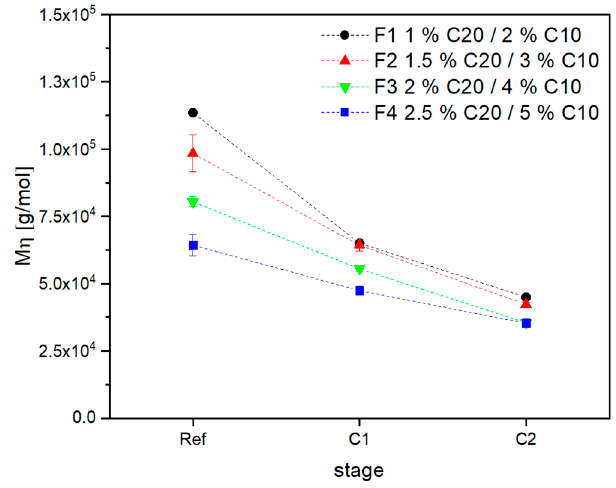
Figure 20. Viscosity average molar mass of the four formulations in different stages.